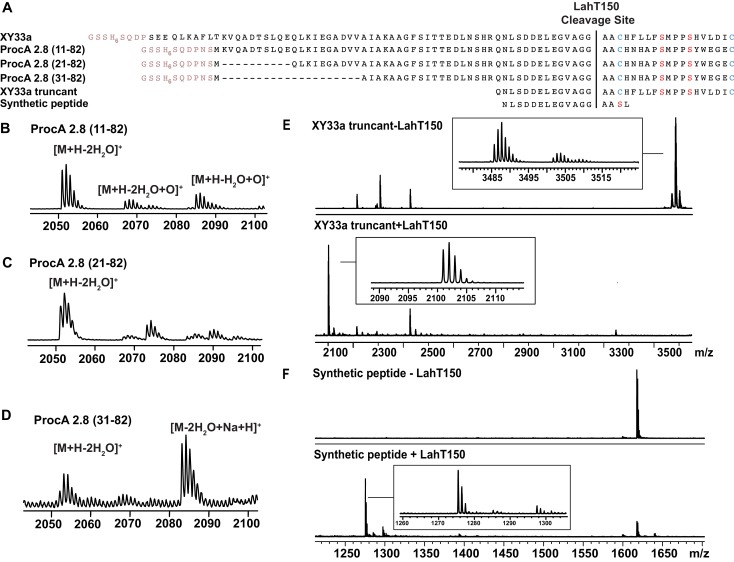
Determination of a minimum sequence for LahT150 catalysis.(A) Sequence alignment of XY33a, ProcA2.8 (11–82), (21-82 , 31-82) and the XY33a-trypsin generated truncant. (B–E) MALDI ToF MS analysis of the products of N-terminally truncated ProcA2.8 treated with LahT150. LahT150 cleaves all three truncated mutants. ProcA2.8 core peptide mass [M + H-2H2O]+: (theor 2050.8; obs 2051.1). (F) XY33a was treated with trypsin to generate the XY33a truncant shown in panel (B), then the trypsin was inactivated by boiling before treatment with LahT150. LahT150 processed the trypsin-generated XY33a truncant. Core peptide masses: ([M + H]+): XY33a-trypsin truncant (theor 3485.6; obs 3485.7); XY33a-core peptide (theor 2101.0; obs 2100.9). (G) MALDI ToF MS analysis of the synthetic peptide in Figure 4—figure supplement 3A without LahT150 (top panel) and with LahT150 (bottom panel). Synthetic peptide [M + H]+ (theor 1617.8, obs 1617.8), Cleaved synthetic peptide N-terminal fragment [M + H]+ (theor 1275.6, obs 1275.5 Da).